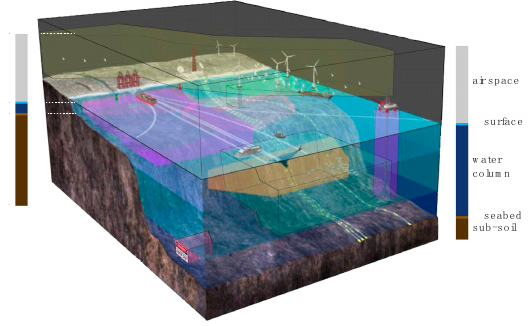
Figure 8. 3D nature of marine parcel ([44], edited).